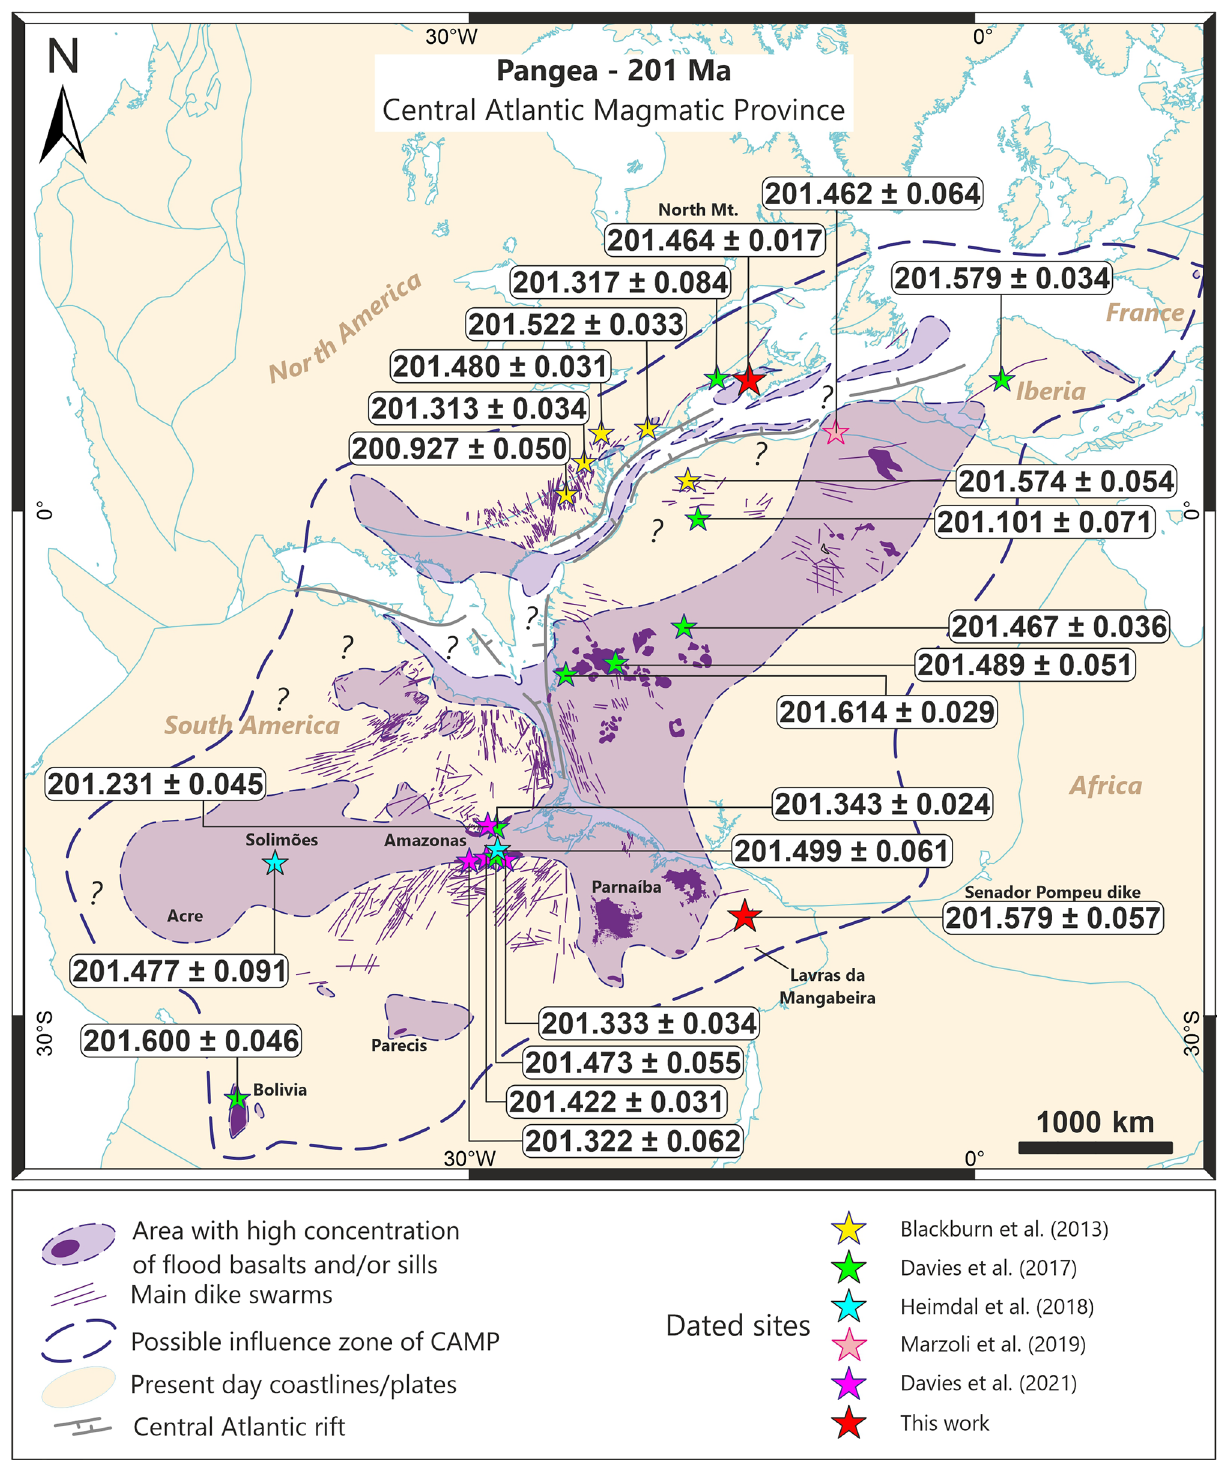
Figure 2. Reconstruction map of the Central Atlantic area during the Triassic-Jurassic Boundary (based on combined models of Ref. 65 ). Position of sills, flows and dikes are shown with locations of critical samples dated by the CA-ID TIMS method (2 σ uncertainty). New ages for the North Mountain Basalt (Canada) and the Senador Pompeu dike (NE Brazil) are presented. Previously dated samples 2,3,6,10 were recalculated to new 230 Th disequilibrium corrections. Map created using software GPlates v2.3 (https:// www. gplat es. org/) and ArcGis Software Package version 10.3.1 (http:// deskt op. arcgis. com/ en/